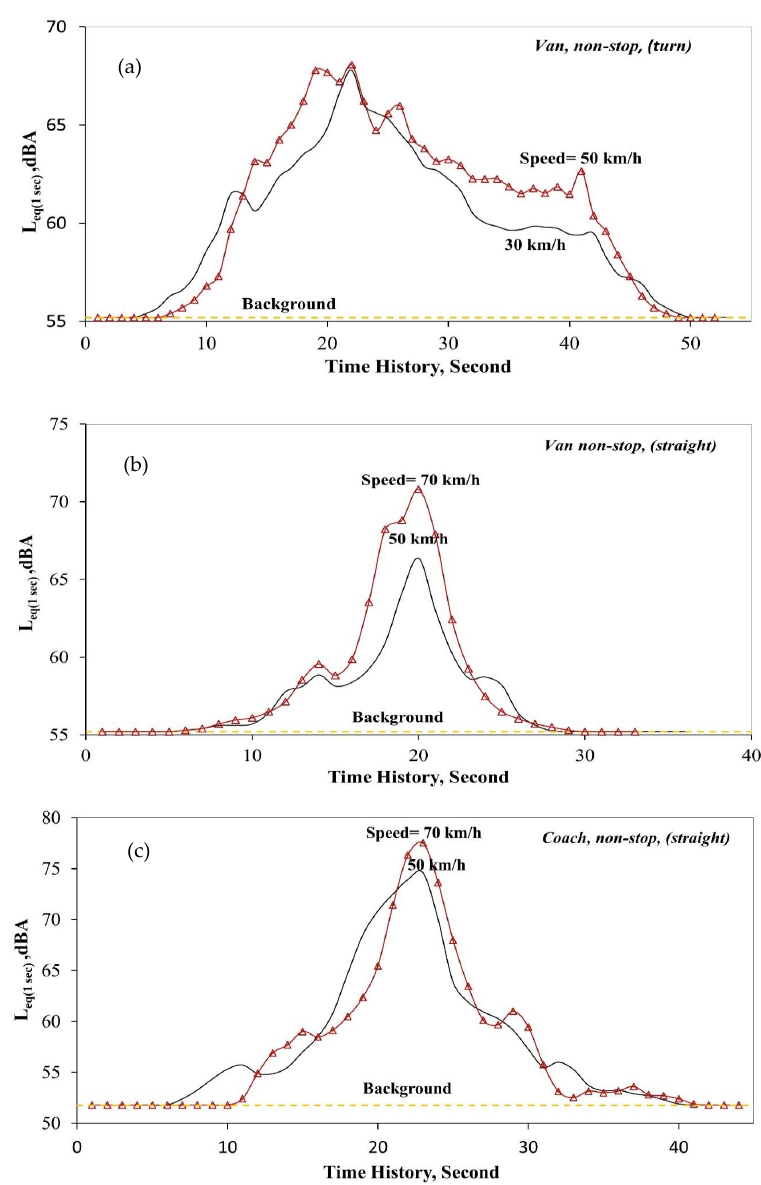
Figure 5. A comparison of average sound pressure levels under “non - stop” traffic scenarios. ( a ) Van, turn; ( b ) Van, straight; ( c ) Coach, straight.